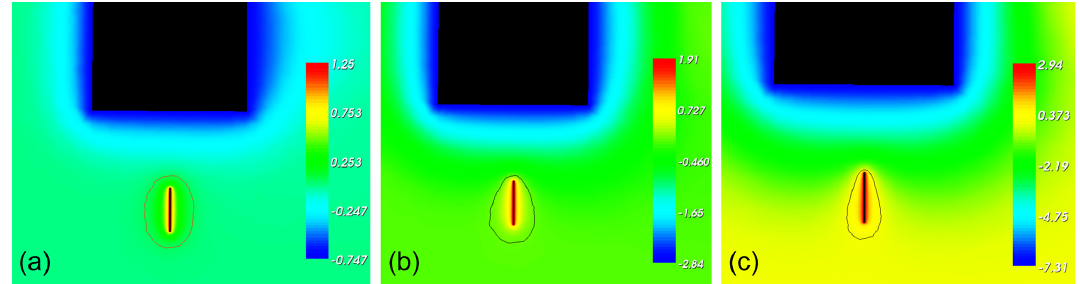
Figure 8. Plasma potential around the S/C mock-up when a bias of 2V (a) , 4.75V (b) and 10.25V (c) is applied to the probe, together with the isolevel curve at 0.05V (linear scale, inV).